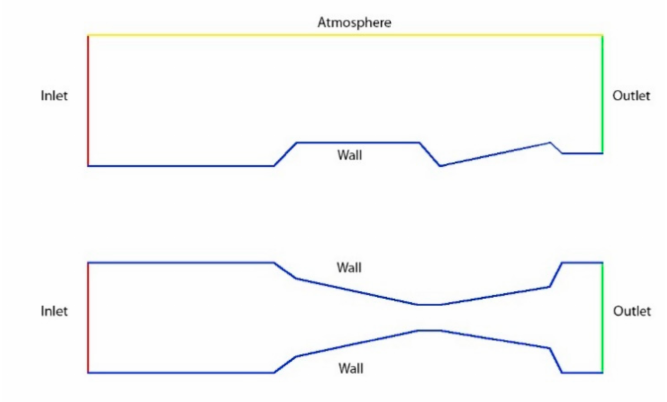
Figure 1. Side view and top view of the boundary condition of the modeled Parshall